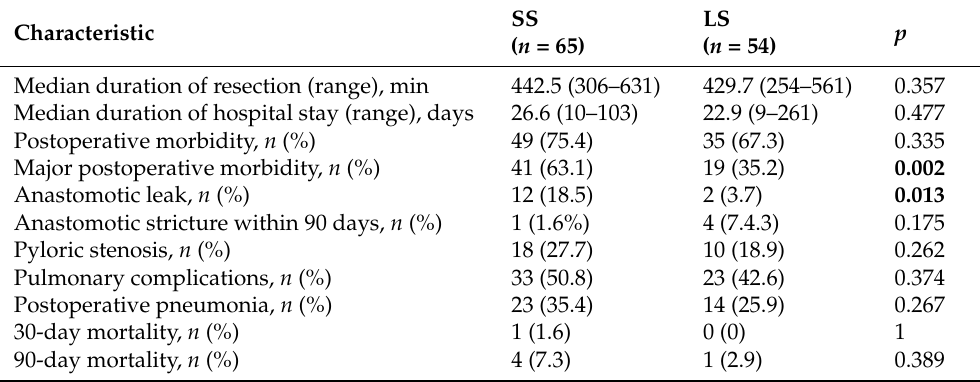
Table 2. Operative and postoperative patient